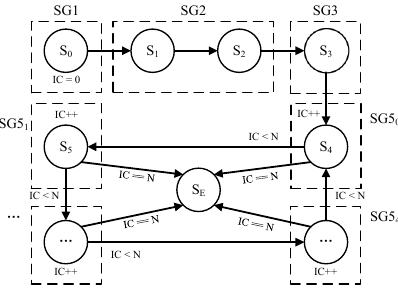
Figure 12: State diagram of the finite state machine for LP = 6 bytes and LS = 8 bytes. The IC (iteration counter) is set to 0 at S 0 . Each time when the FSM leaves SG5, the IC is increased by one. Once the IC equals the iteration number N , the FSM transits to the end state S E .